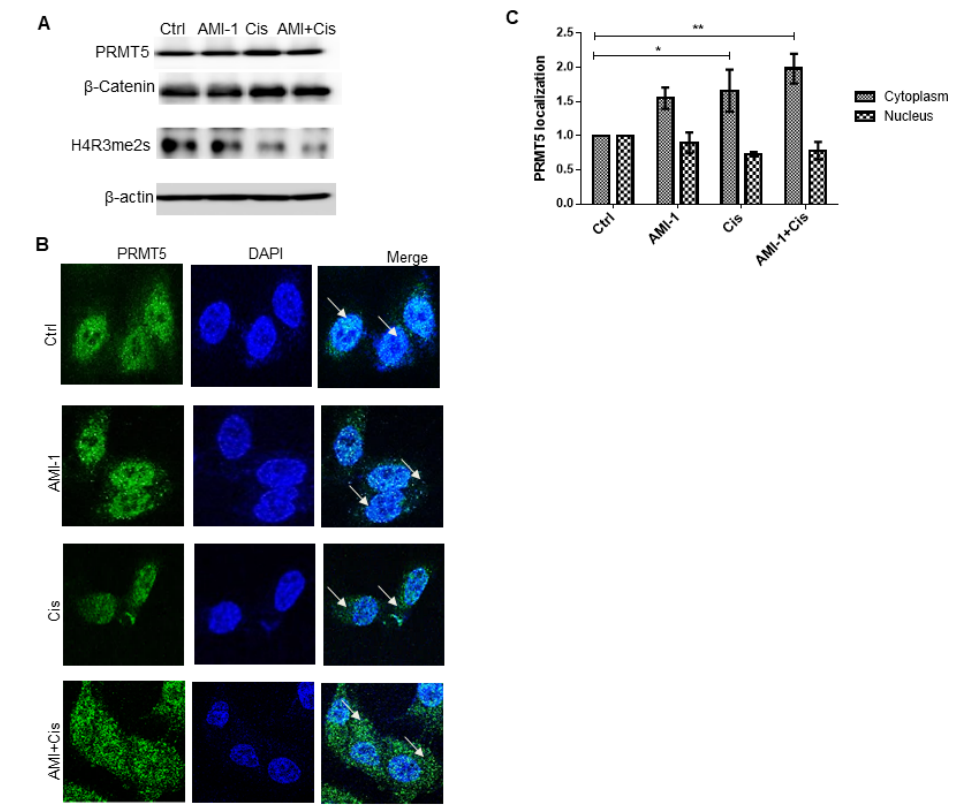
Figure 3. Protein profiling of PRMT5 and its downstream targets; β -catenin and H4R3me2s.; in A549 cells. A549 cells were treated with AMI-1.; cisplatin or both and harvested after 48 h of treatment. ( A ) Representative Western blot of PRMT5; β -catenin.; and H4R3me2s levels in A549 cells after administration of AMI-1 and/or cisplatin for 48 h. ß-actin was used as a loading control. AMI-1 (10 μ M) in combination with cisplatin markedly reduced the methylation of histone H3. ( B ) Immunofluorescence staining of A549 cells exposed to different treatment conditions left untreated than were stained for DNA (DAPI; blue).; PRMT5 (green). Arrows indicate subcellular localization of PRMT5 in A549 lung cancer cells under 40× objective lens. ( C ) Bar graph showing the PRMT5 cellular localization in cells treated with AMI-1 and cisplatin alone or in combination in comparison to untreated cells. (*) Represents the statistically significant change in viability between the indicated treatment groups at given time points. ** p < 0.01.